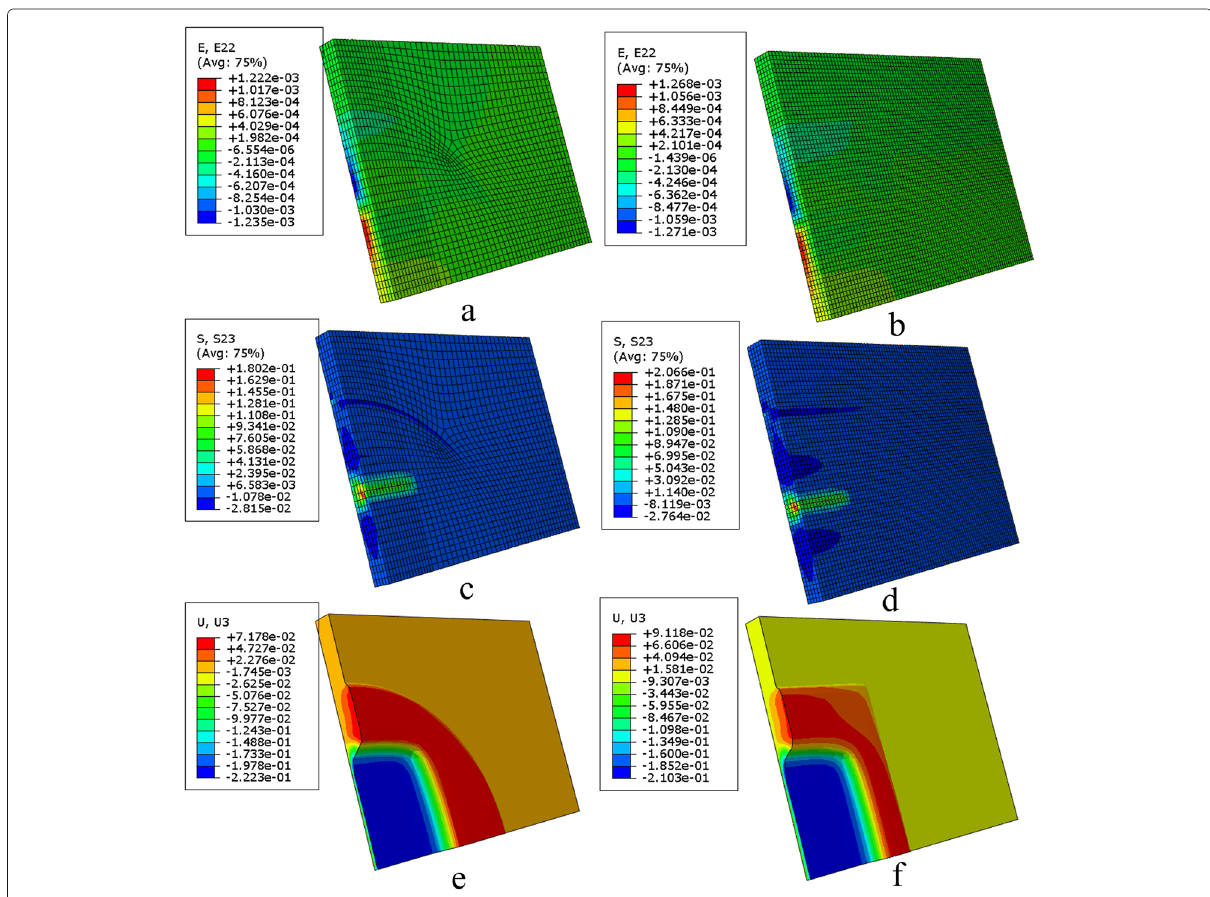
Fig. 10 Comparisons of circular and rectangular shape for large repairs, a and b are horizontal strain (E11) at 0.17s, c and d are shear stress (S13) at 0.17s, e and f are vertical deformation (U3) at 59.03s Table 5 Pavement effect of large size repairs for circle and rectangle at different time and locations Time Period description Location Comparison % Horizontal strain E22/ MPa